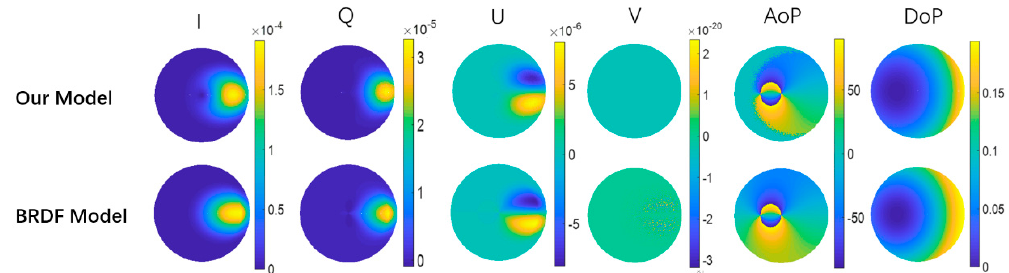
Figure 4. Comparison of the results obtained by our model and the analytical bidirectional reflectance distribution function (BRDF)